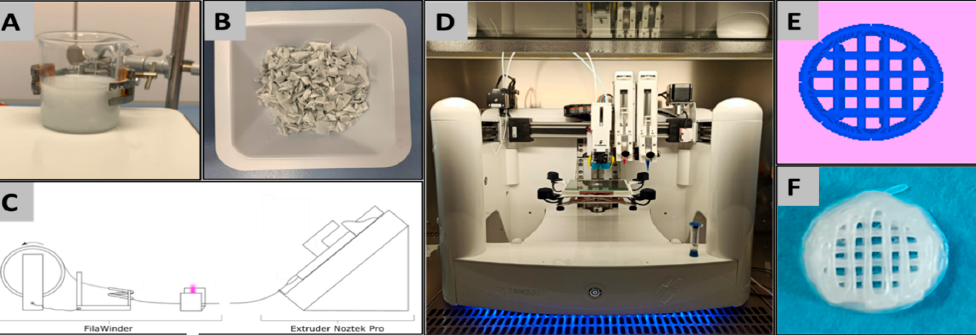
Figure 12. ( A ) PCL+BCP suspension, ( B ) PCL+BCP pellets, ( C ) schematic of Notztek Pro Extruder and FilaWinder assembly, ( D ) REG4Life Bioprinter, ( E ) scaffold design in REGEMAT designer V1.4.9, ( F ) 3D-printed scaffolds.